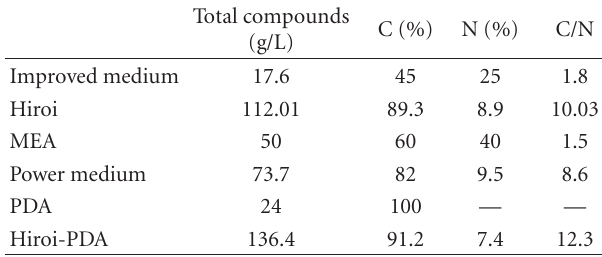
Table 3: Total ingredients of compounds in medium and the percentage of carbon and nitrogen along with C/N